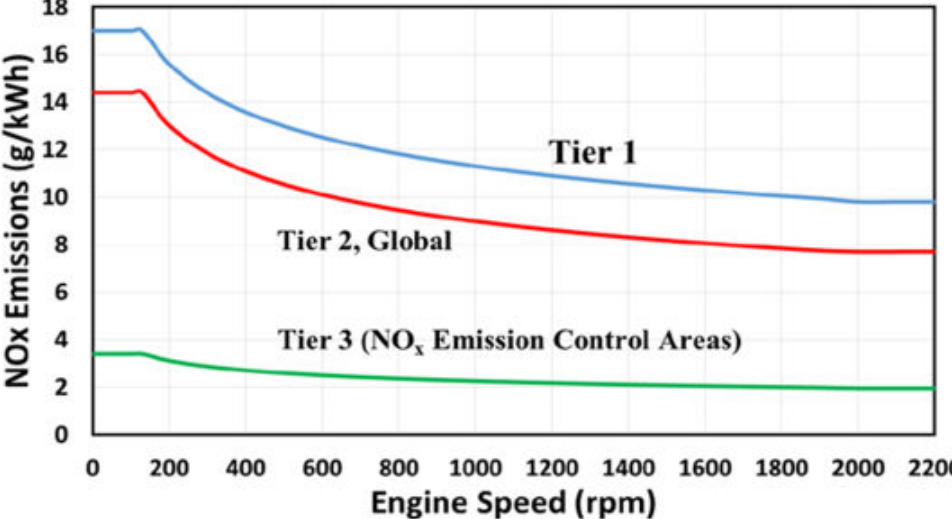
Figure A1. Allowed NOx emissions per Tier I, II and III standards. Y axis is NOx emissions (g/kWh), and the X axis is engine speed (rpm). Adopted from